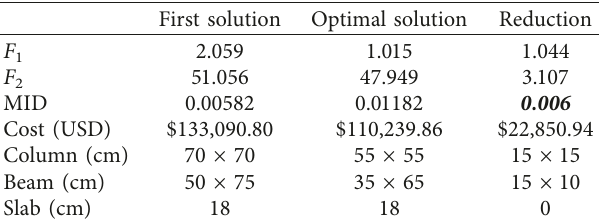
Figure 8: Behavior of objective function F 2 for model RC-3: (a) all individuals per generation; (b) average values of objective per generation. Table 2: Differences between the first and best solution of first execution of the procedure for the RC-3 Model.